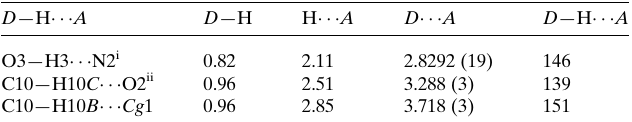
Table 1 Hydrogen-bond geometry (A˚ , (cid:4) ). Cg 1 is the centroid of the C1–C6 benzene ring.